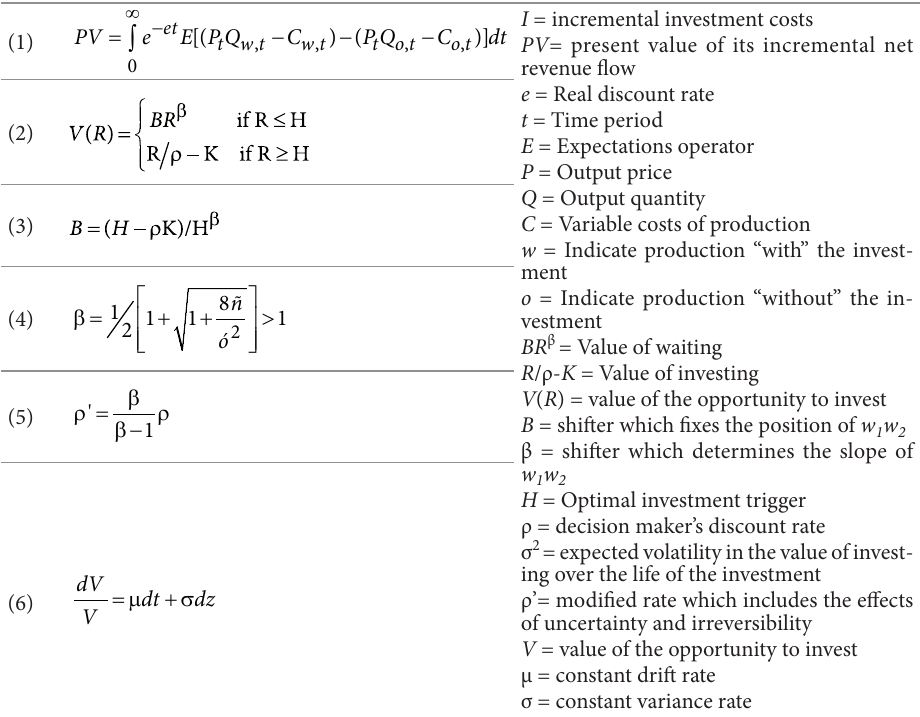
Table 1. Equations and description of the